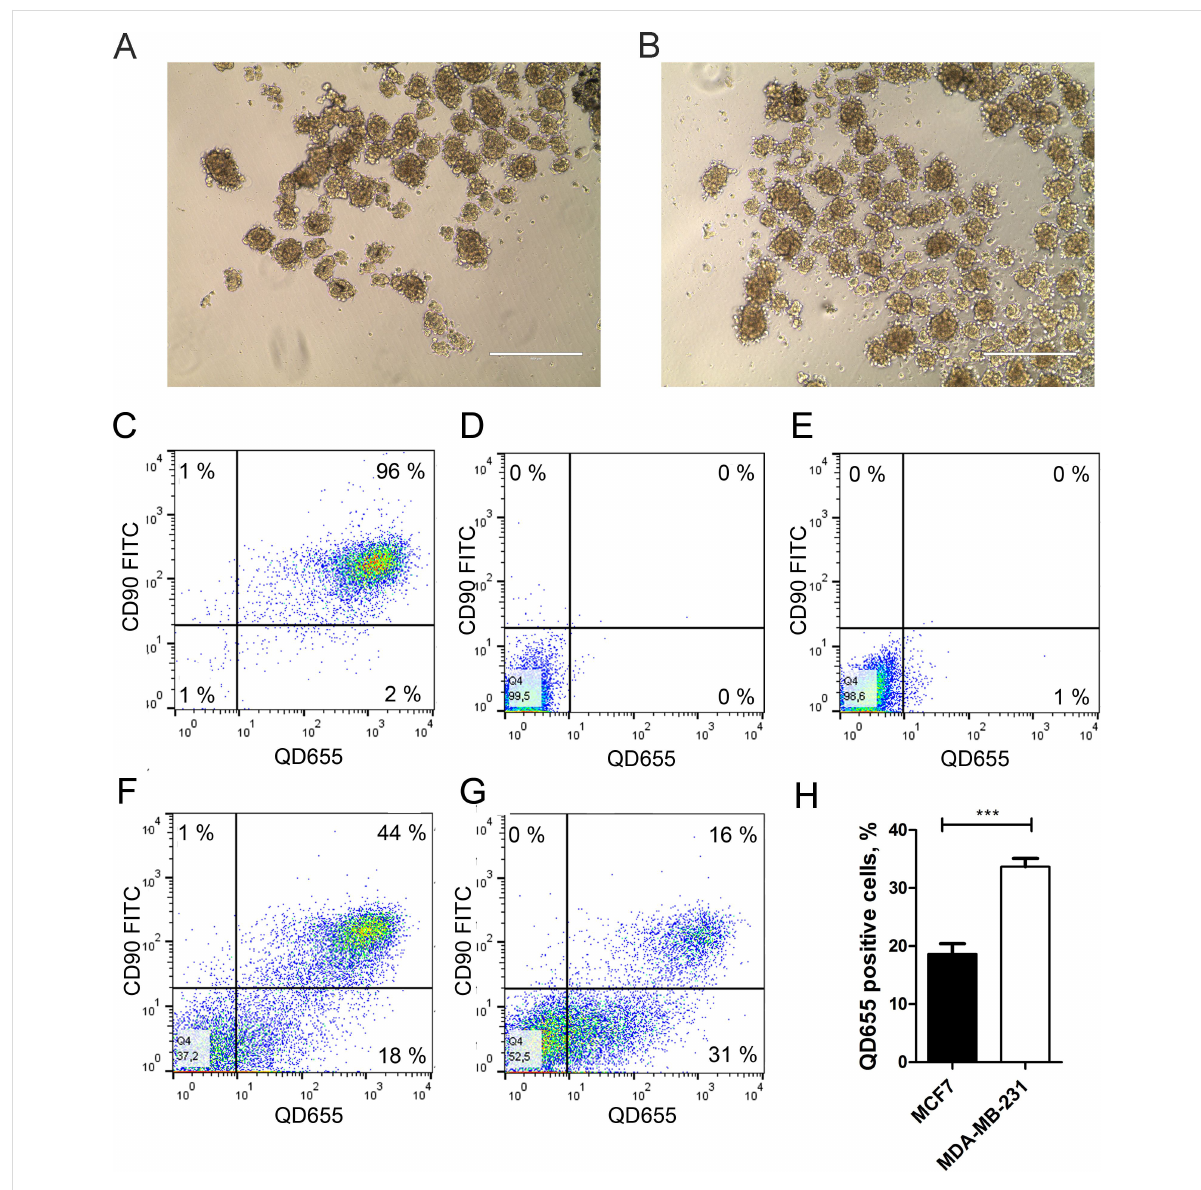
Figure 6: Quantum dot (QD) uptake in MCF7 and MDA-MB-231 cells in 3D co-culture. (A) Morphology of MSC/MCF7 and (B) MSC/MDA-MB-231 spheroids after 24 h of co-culture. Scale bar – 400 μ m. (C) QD-loaded mesenchymal stem cells (MSCs), (D) MCF7 and (E) MDA-MB-231 cells were stained with CD90 to distinguish MSCs and cancer cell populations. Lower right quadrant in the dot plot shows the single QD positive population (QD- labelled cancer cells) in MSC/MCF7 (F) and MSC/MDA-MB-231 (G) 3D co-cultures. Representative data shown. (H) QD transfer efficiency from MSCs to cancer cells illustrated by the percentage of QD-positive/CD90-negative cells ( n = 3). *** p -value <